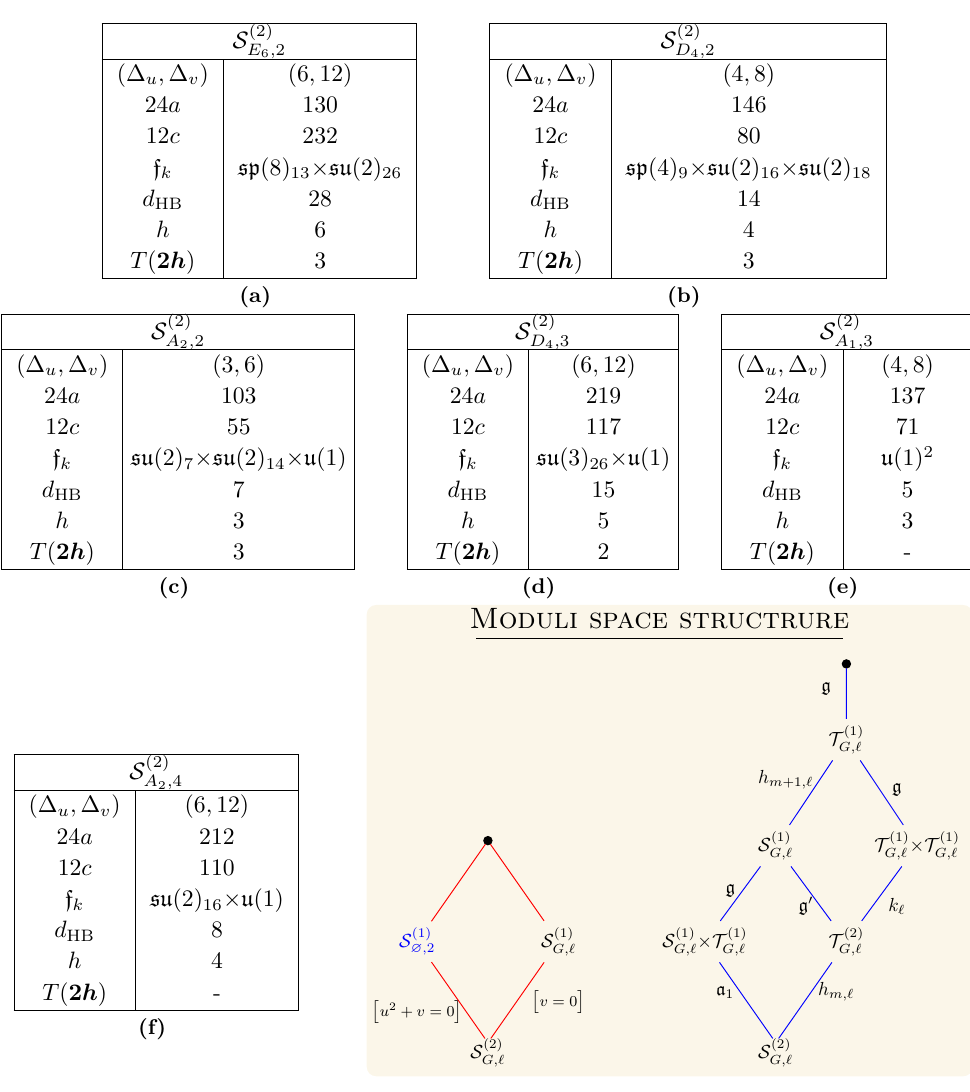
Figure 47. In this figure we report the relevant CFT data for the S (2) and the g 0 are defined as in figure